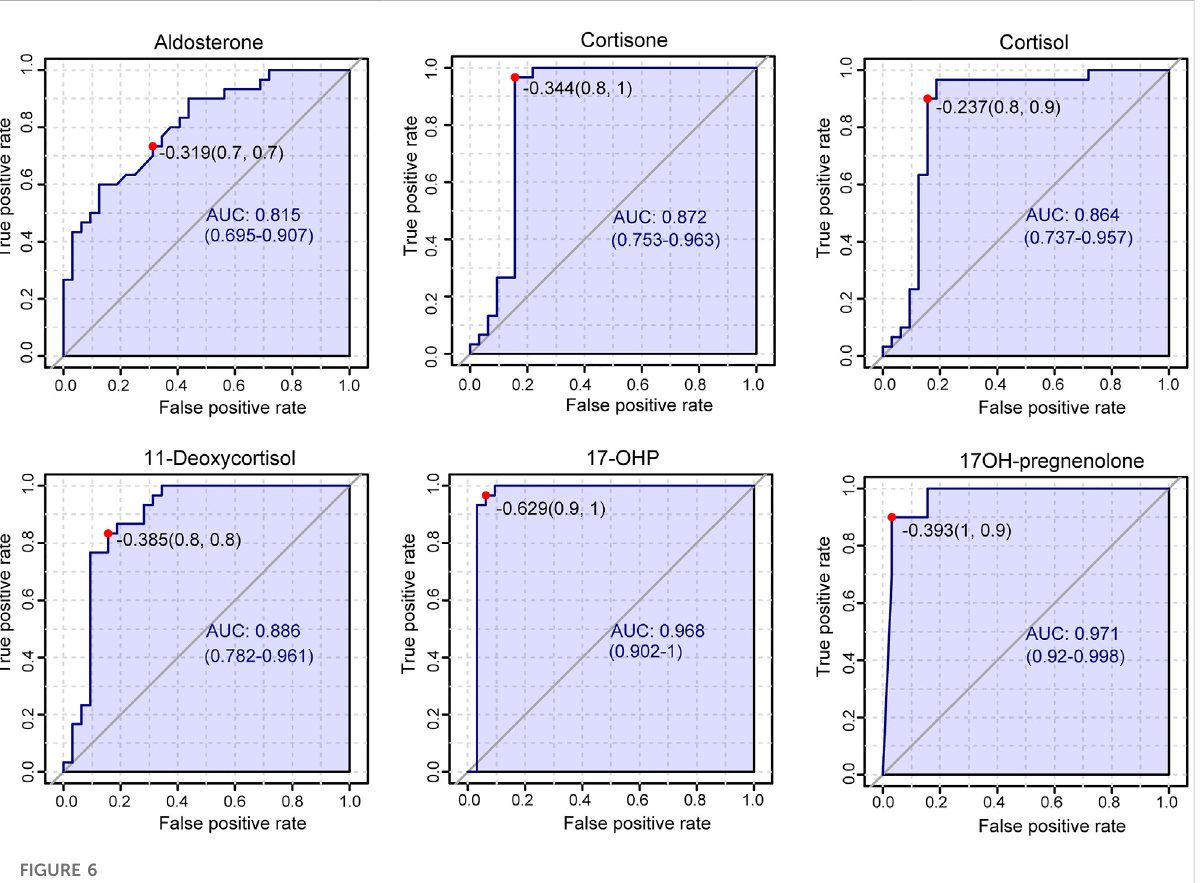
FIGURE 6 Results of receiver operating characteristic curve (ROC)